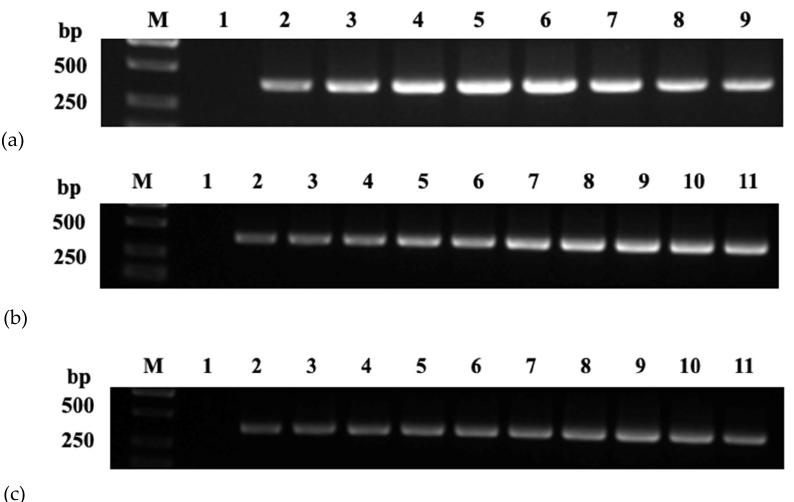
Figure 2. Optimization of annealing temperature ( a ), primer concentration ( b ), and template concen- tration ( c ): ( a ) Lane M, DL 2000 Marker; Lane 1, negative control; Lanes 2–9, 50.0, 50.7, 51.9, 53.7, 56.1, 58.0, 59.2, and 60.0 ◦ C; ( b ) Lane M, DL 2000 Marker; Lane 1, negative control; Lanes 2–11,